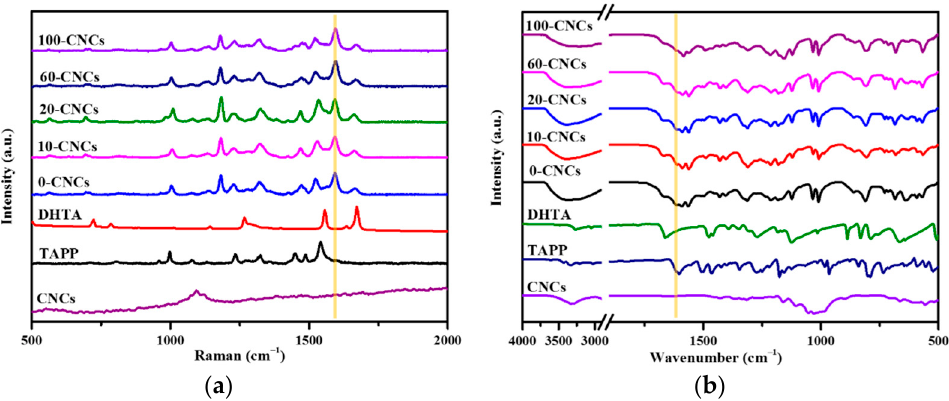
Figure 3. ( a ) Raman spectra of the films with 0, 10, 20, 60, 100 μ L CNCs and monomers; ( b ) FTIR spectra of the films with 0, 10, 20, 60, 100 μ L CNCs and monomers.